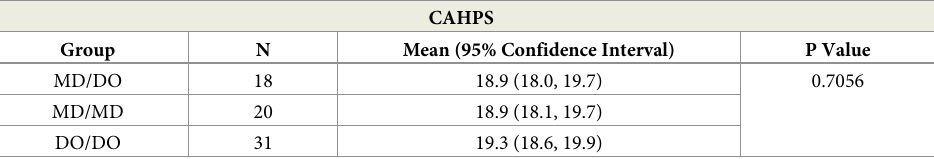
Table 4. Differences in CAHPS scores among the MD/MD, MD/DO, and DO/DO